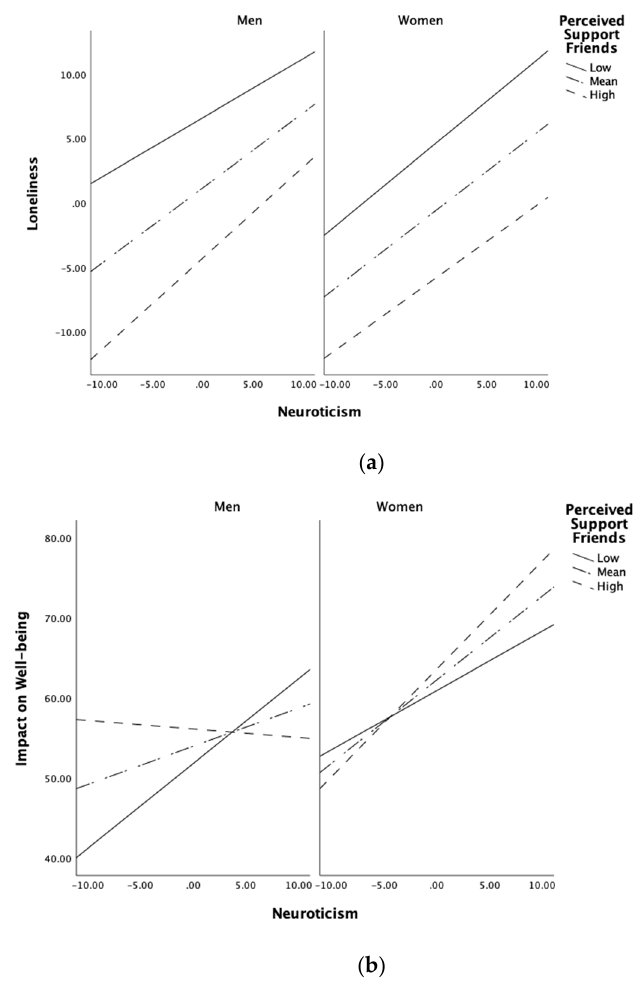
Figure 2. ( a ) Regression of loneliness on neuroticism at three levels of perceived support from friends by gender; ( b ) regression of well-being on neuroticism at three levels of perceived support from friends by gender. Values are plotted using simple slopes equations of the regression for conditional effects of perceived support at three levels, for men ( left ) and women ( right